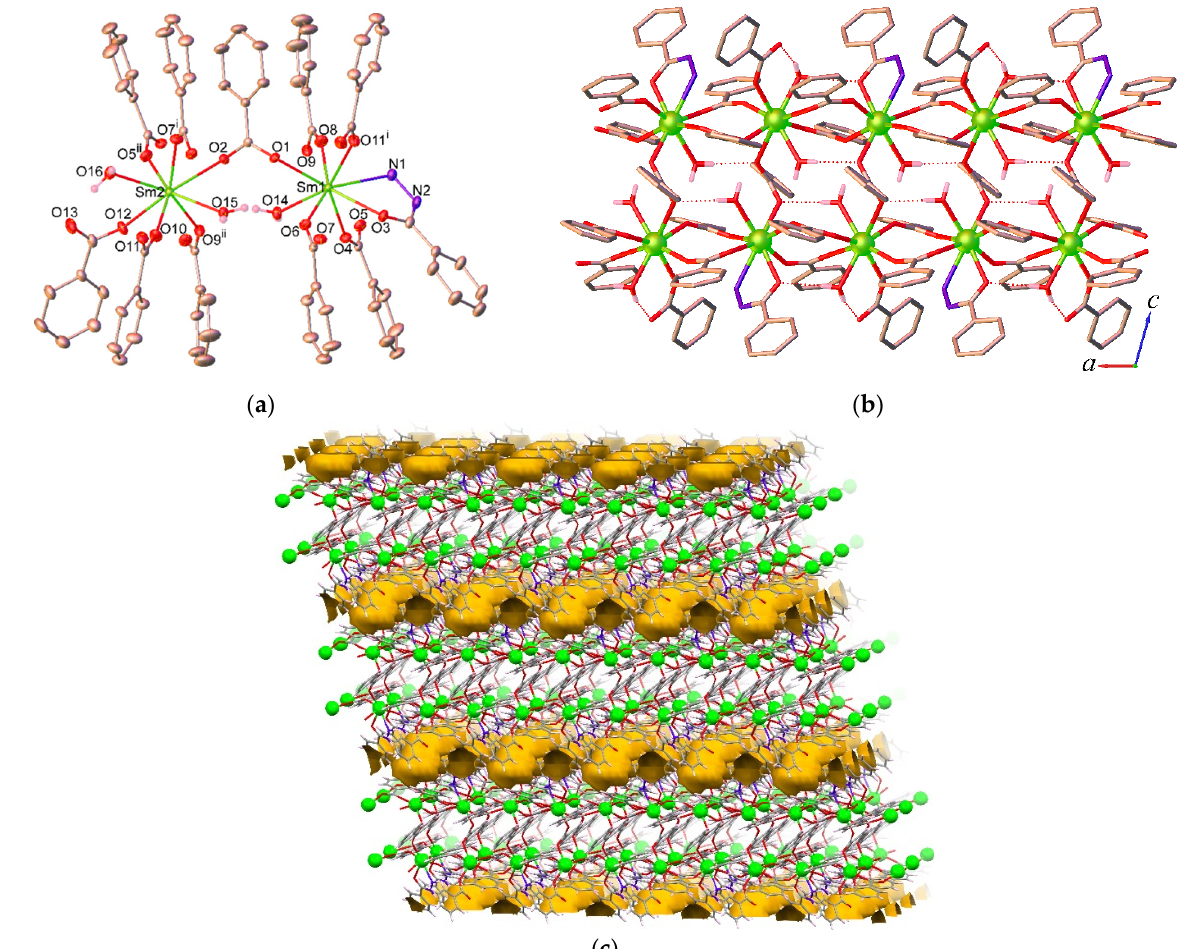
Figure 1. ( a ) Coordination environment of the Sm 3+ ion in 1 . The thermal ellipsoids are drawn at the 30% probability level for non-hydrogen atoms. Hydrogen atoms attached on the carbon and nitrogen atoms are omitted for clarity. Symmetry codes: (i) − x , 1 − y , 1 − z ; (ii) 1 − x , 1 − y , 1 − z . ( b ) One-dimensional double-chain structure of 1 viewed along the b axis. Hydrogen atoms attached on the carbon and nitrogen atoms are omitted for clarity. ( c ) Packing supramolecular structure of 1 viewed approximately along the b axis; yellow colored space marks the contact surface of the void spaces.